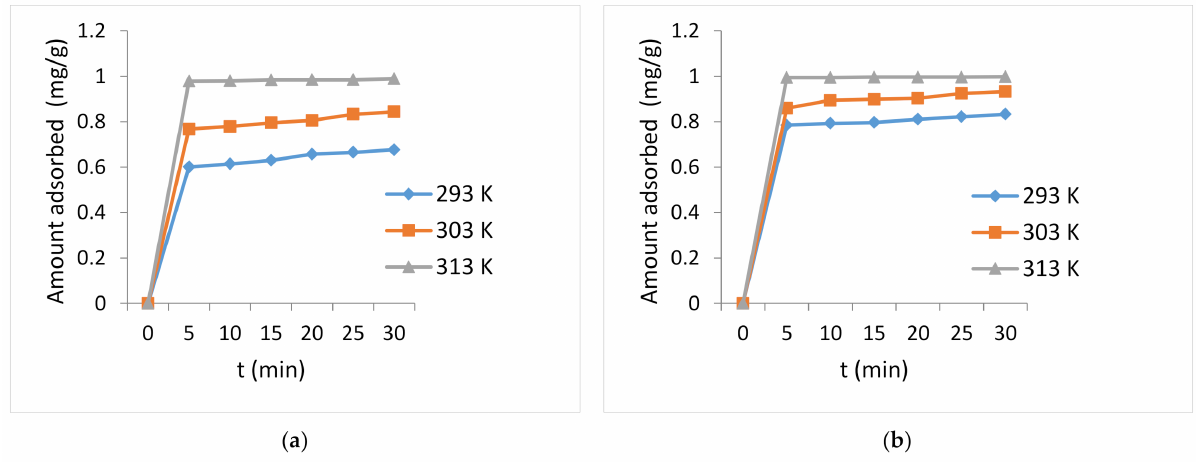
Figure 8. Adsorption kinetics for the adsorption of ( a ) AR4 ( b ) MB onto prepared